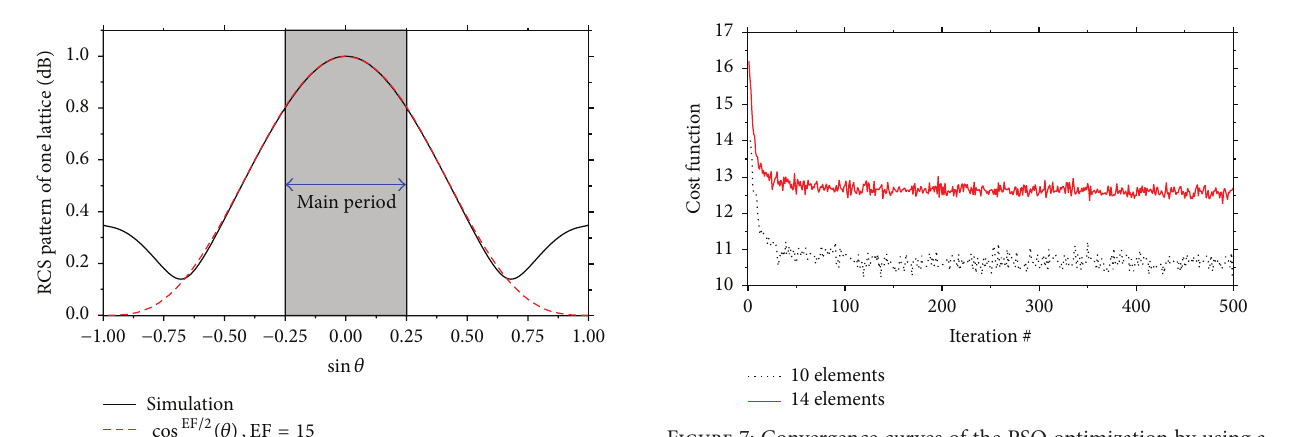
Figure 7: Convergence curves of the PSO optimization by using a 100-agent swarm for 500 iterations and applying the cost function defined in